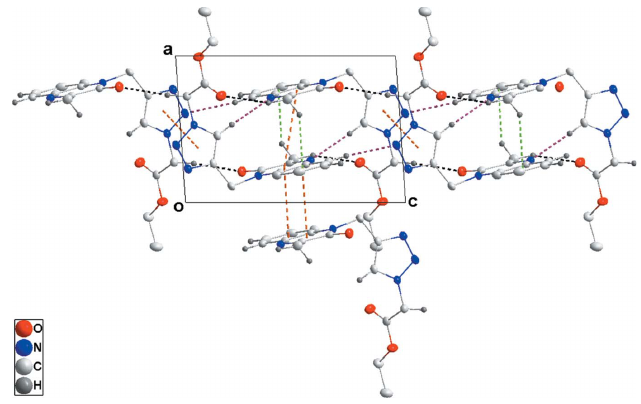
Figure 2 Detail of the intermolecular interactions viewed along the b -axis